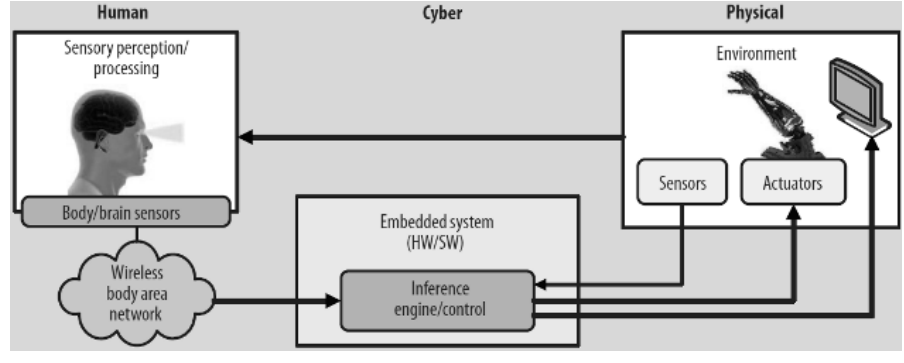
Figure 3. HiTLCPS (see [34]).